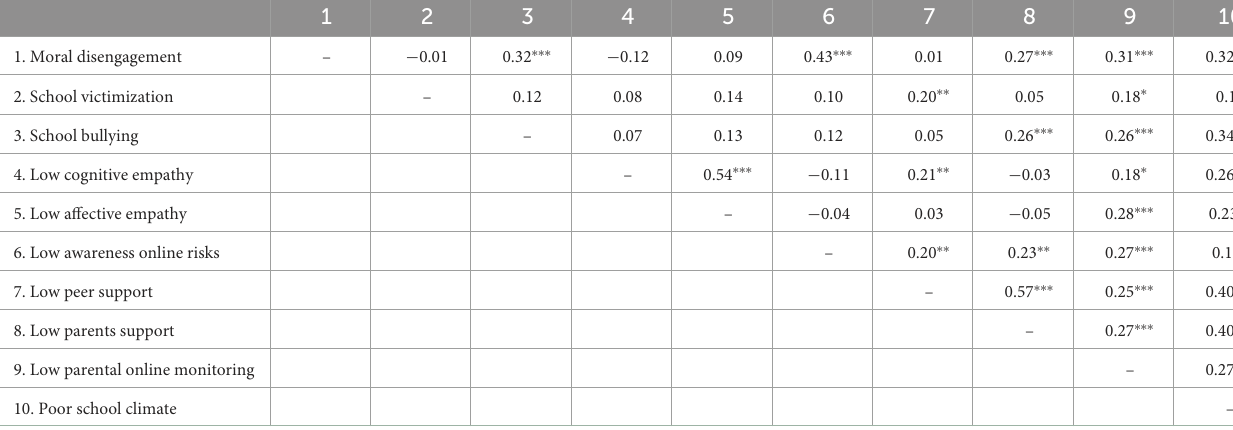
TABLE 5 Correlation matrix for onset of